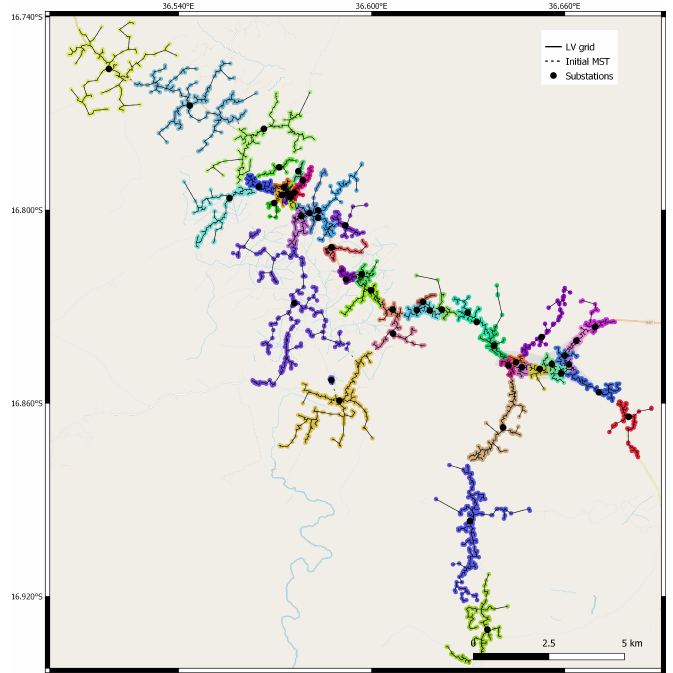
Figure 8. Results of Lukes clustering in Namanjavira.